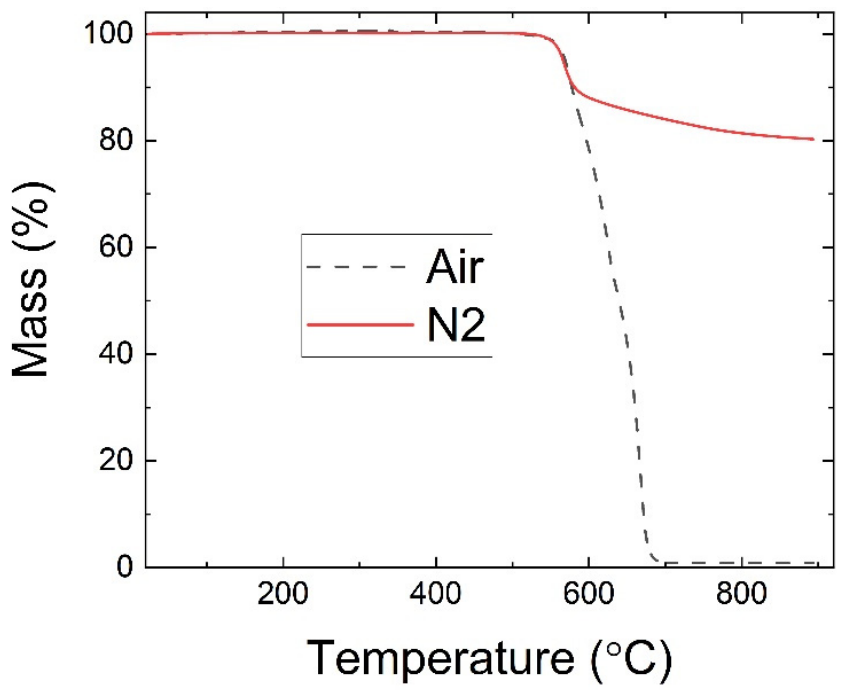
Figure 1. TGA data of printing filament run in air and under nitrogen flow.